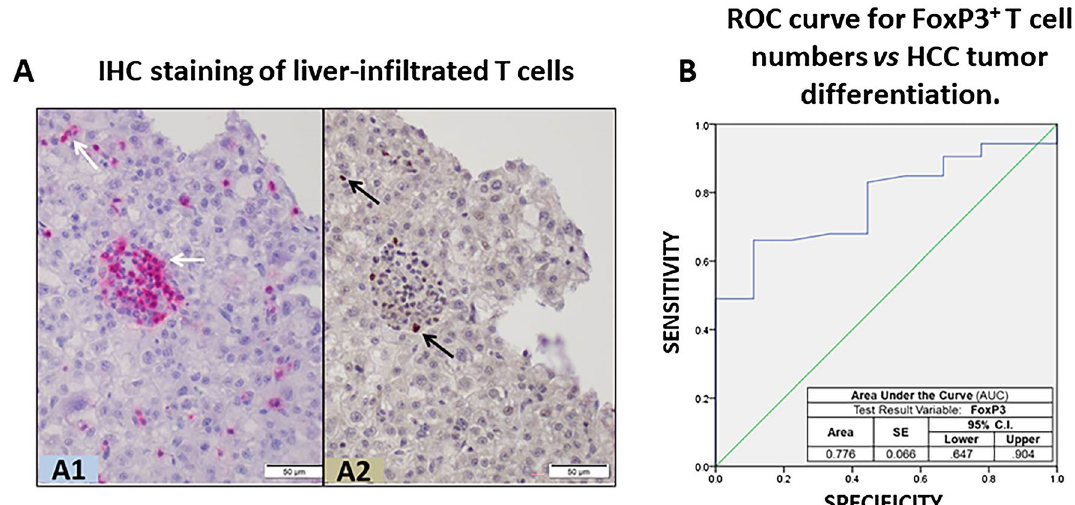
Figure 1. Infiltration of T cells in HCC samples from transplanted liver patients. ( A ) Conventional IHC staining of liver-infiltrated T cells in a representative section of paraffin-embedded HCC-bearing liver reveals: ( A1 ) presence of T cell-like CD3 + cells (purple dots showing clusters of CD3 + cells) in the liver sinusoids and parenchyma, and ( A2 ) FoxP3 + cells (brown dots); scale bar 50 µm. ( B ) Receiver operating characteristic (ROC) curve comparing sensitivity and specificity for the risk index of poor HCC differentiation across a range of FoxP3 + infiltrate values.